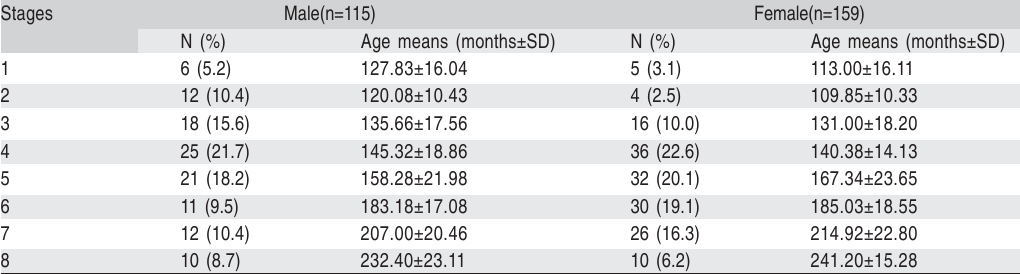
Table 4. Tooth mineralization chronology of lower third molars according to